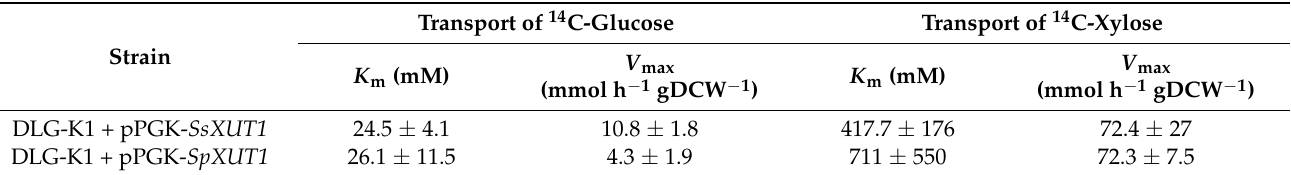
Figure 3. Kinetics of glucose ( a ) or xylose ( b ) transport by strain DLG-K1 transformed with plasmid pPGK- SsXUT1 (black symbols) or plasmid pPGK- SpXUT1 (open symbols). Cells pre-grown in 2% maltose were used to determine the initial rates of uptake of the indicated labeled sugar concentrations at 25 °C. Table 2. Kinetic parameters of 14 C-glucose and 14 C-xylose transport by the SsXUT1 and SpXUT1 permeases at 25 ◦ C, in cells grown in YNB-2%